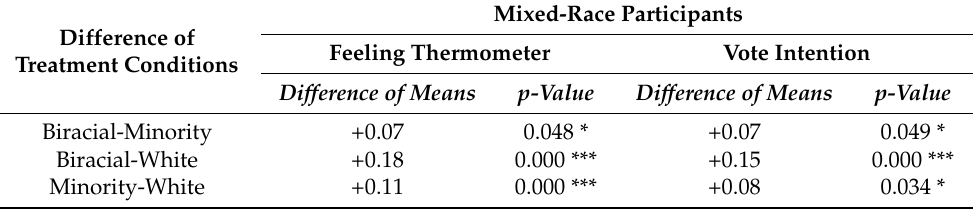
Figure 1. Mean feeling thermometer and vote intention ratings of hypothetical candidates. All six treatments are represented here and grouped by each identity cue (e.g., “White” denotes candidates from both the Asian and White heritage and Black and White heritage treatment conditions who identified as “European American”. Sample includes only mixed-race participants who indicated two or more racial heritages among their parents. X -axis denotes different treatment groups based on the identity cued by our hypothetical candidates. Note: error bars denote 95% confidence intervals. Table 1. Results from difference-of-means t -tests for all possible treatment group comparisons in Figure 1.